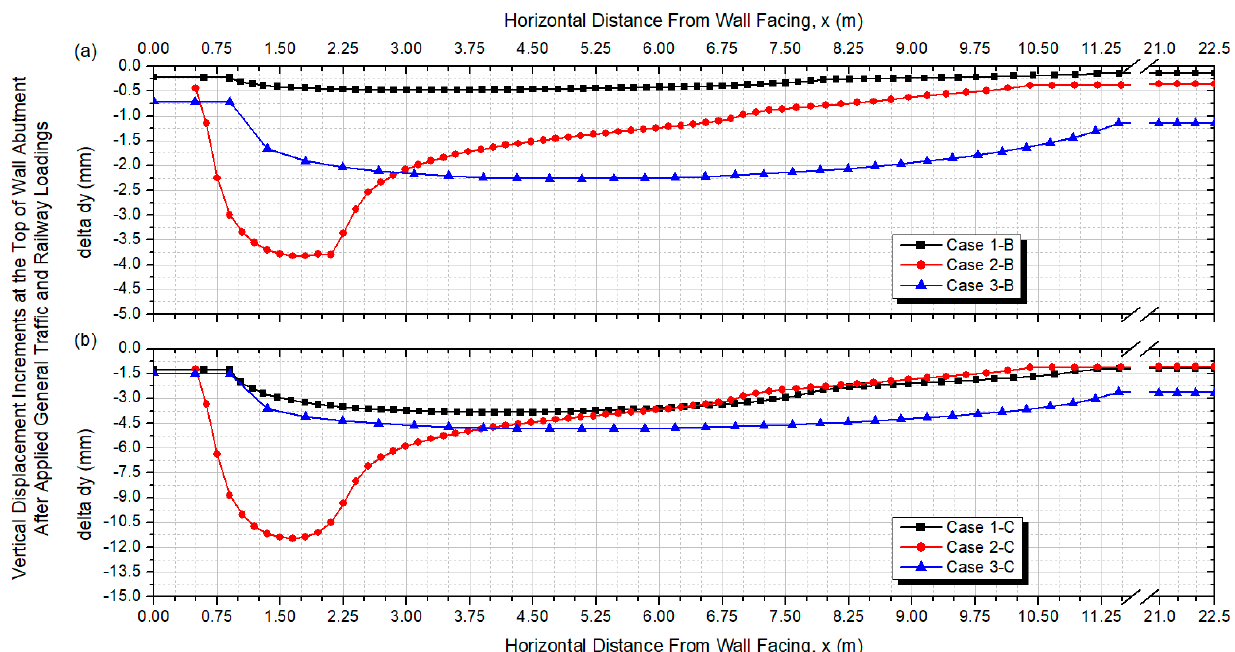
Figure 10. Vertical displacement increments at the top of the wall abutment, ∆ dy (mm), after the applied static loadings: ( a ) Case 1B, 2B 3B (general traffic loading) and ( b ) Case 1C, 2C, 3C (railway loading).